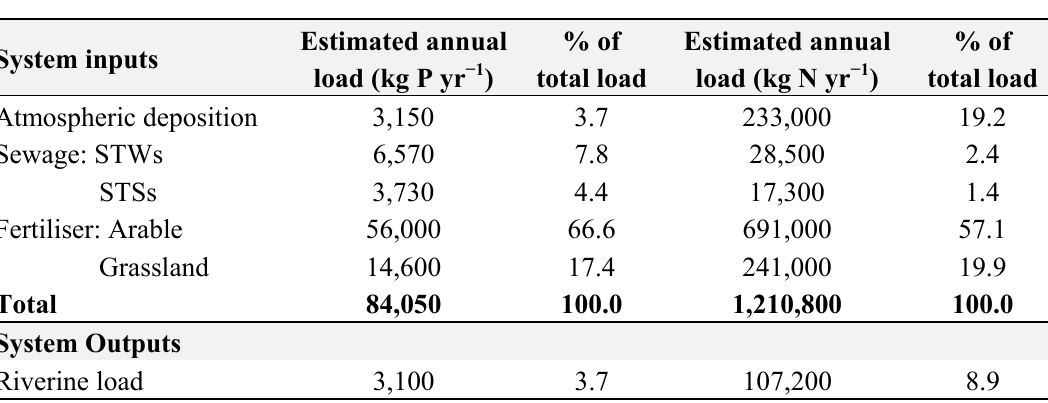
Table 6. Partial mass balance for P and N in the Enborne catchment *